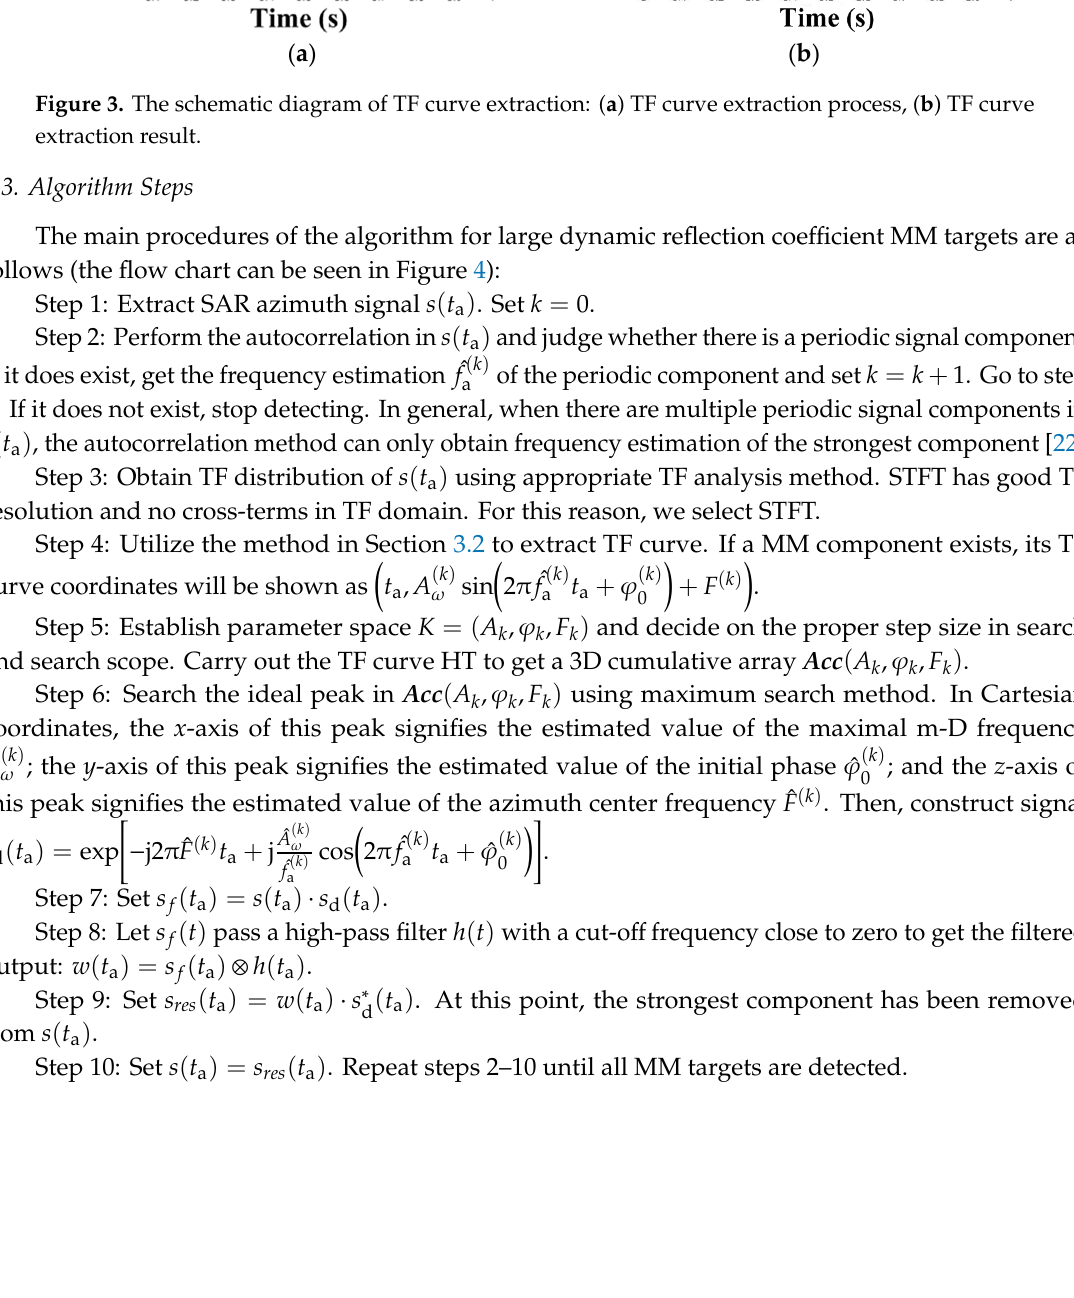
Figure 4. The algorithm flow chart.